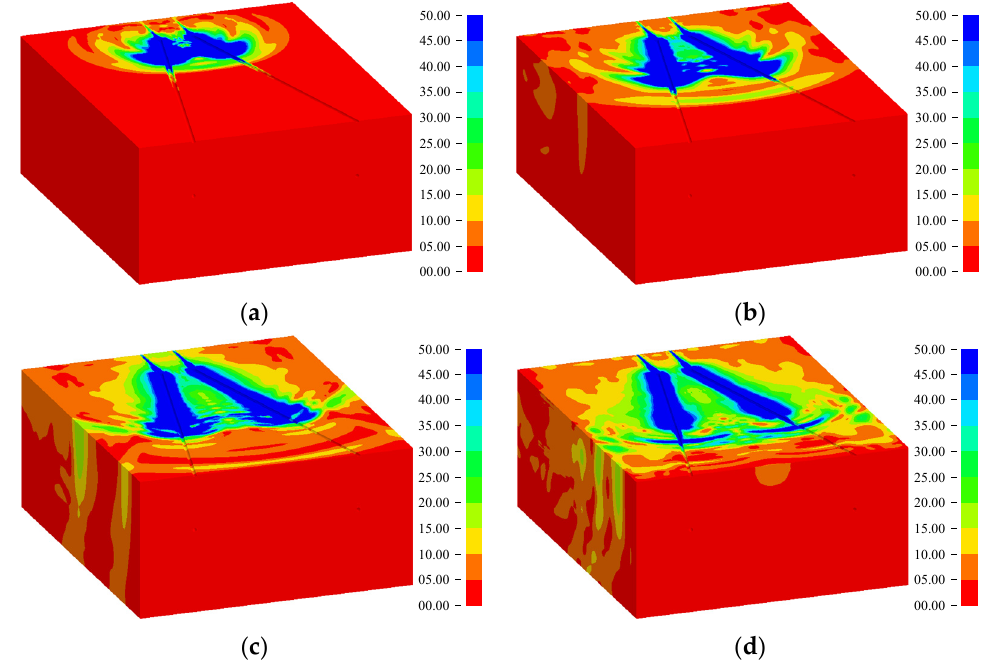
Figure 6. Stress wave propagation under the condition of Φ 42 mm holes matching Φ 35 mm cartridges. ( a ) Time = 160 µs. ( b )Time = 320 µs. ( c ) Time = 470 µs. ( d ) Time = 600 µs.